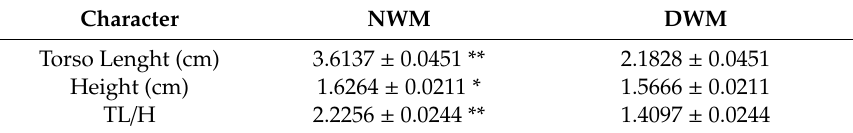
Table 1. Phenotype di ff erences between normal and dwarf white sailfin